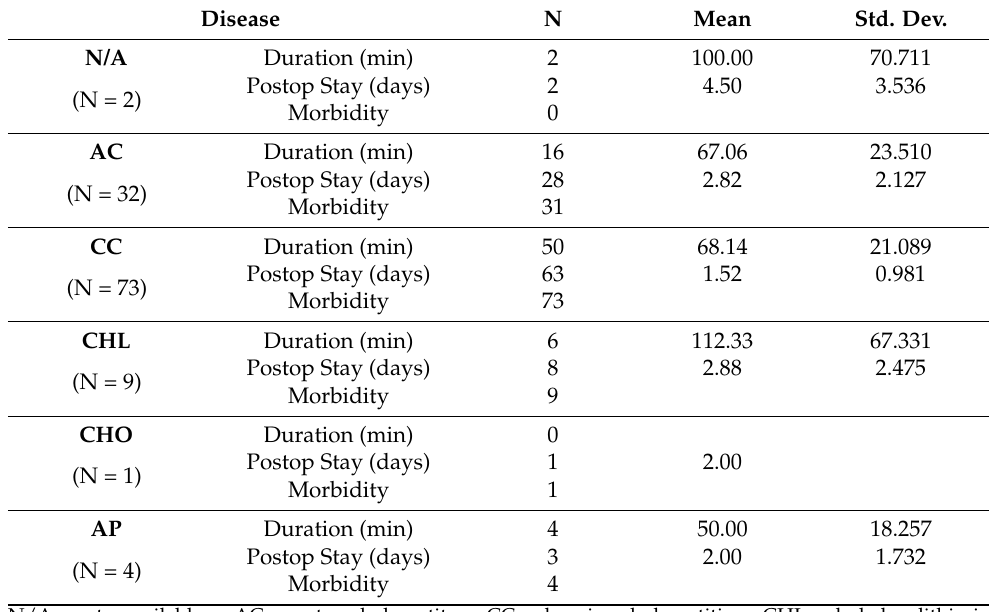
Table 2. Duration of surgery, postoperative stay, and morbidity according to